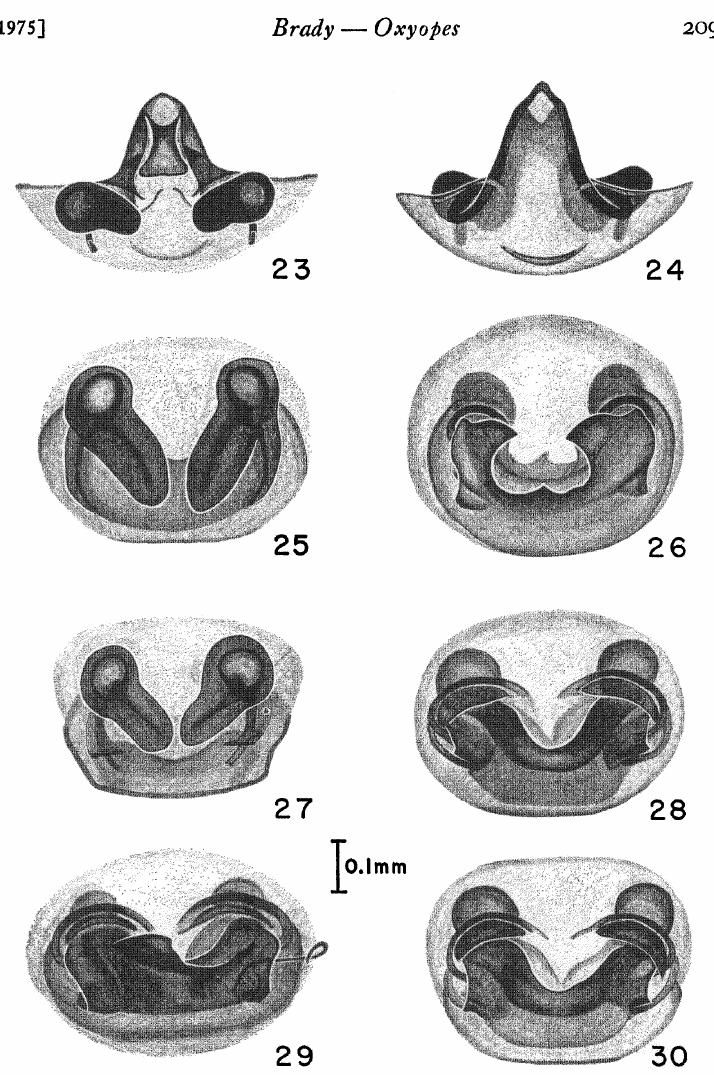
Figs. 23-24. Oxyopes salticus Hentz, female from Horsetail Falls, Nuevo Leon, 7 July 1972. 23. Internal genitalia. 24. Epigynum. Figs. 25-26. Oxyopes bifidus F.O.P.-Cambridge, female from Compo- stela, Nayarit, 12 July 1972. 25. Internal genitalia. 26. Epigynum. Figs. 27-30. Oxyoes bifidus F.O.P.-Cambridge, females from Rio de las Flores, Chlapas, 15 Sept. 1947. 27. Internal genitalia. 28-30.